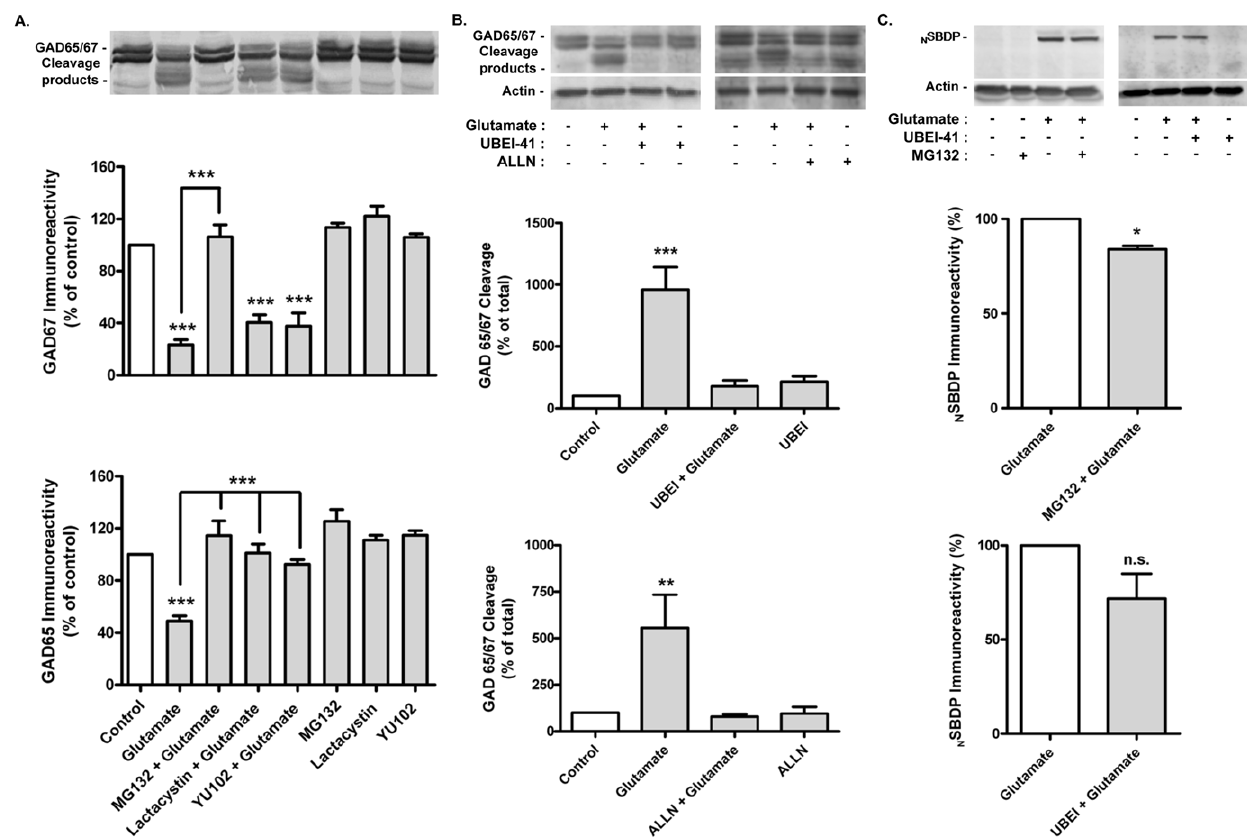
Figure 4. Proteasome and ubiquitin-activating enzyme (E1) inhibitors prevent glutamate–induced GAD65/67 cleavage. Cultured hippocampal neurons were pre-incubated or not with 50 m M of UBEI-41 (E1 inhibitor), for 1h, or with the proteasome inhibitors MG132 (1 m M), lactacystin (10 m M) or YU102 (10 m M), for 30 min, before excitotoxic stimulation with glutamate (125 m M), for 20 min. The cells were further incubated in culture conditioned medium (with or without chemical inhibitors) for 5h, and the GAD65/67 immunoreactivity was assessed by western blot (A and B). Incubation with the calpain inhibitor ALLN (10 m M) was performed under the same conditions. The average results in (A) represent the changes in GAD65 or GAD67 immunoreactivity. In panel (B) GAD cleavage was calculated as a percentage of the total enzyme content (GAD65/67). When calpain activity was evaluated through formation of N-terminal spectrin breakdown products ( N SBDPs) the cells were incubated for 30 min after the toxic insult (C). The effect of MG132 and UBEI-41 on calpain activation is expressed as a percentage of the activity measured in the absence of the protease inhibitors. Results are means 6 SEM of 3–4 different experiments, performed in independent preparations. Statistical analysis was performed using one-way ANOVA, followed by Bonferroni’s Multiple Comparison Test (A and B) or the Student’s t test (C). *** p ,